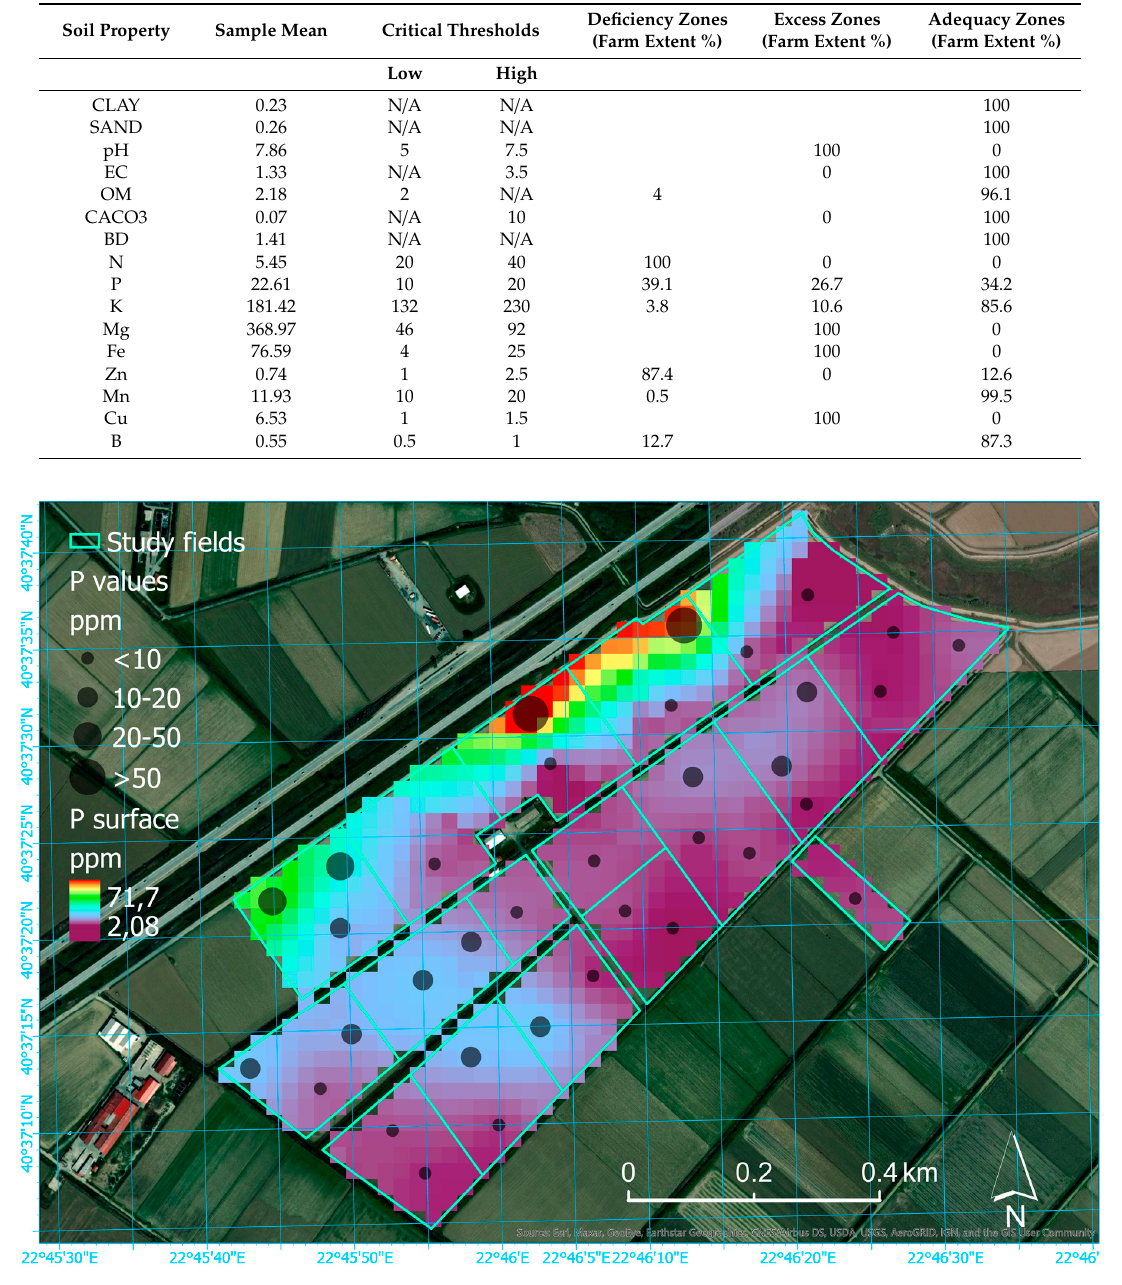
Figure 13. Location of soil samples, their P values (with proportional symbols) and the interpolated phosphorus content surface; an example from the central sector of the farm.